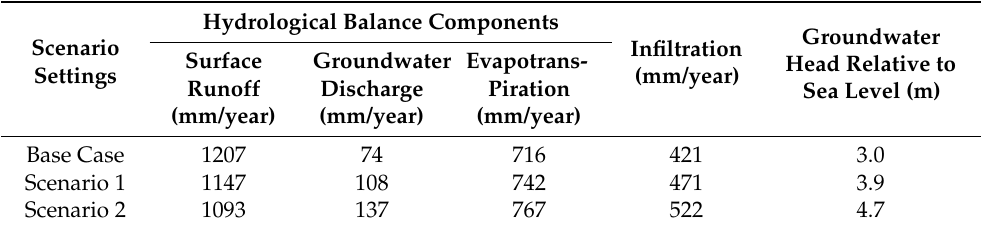
Table 3. The hydrological balance for the three scenarios when groundwater system reaches an